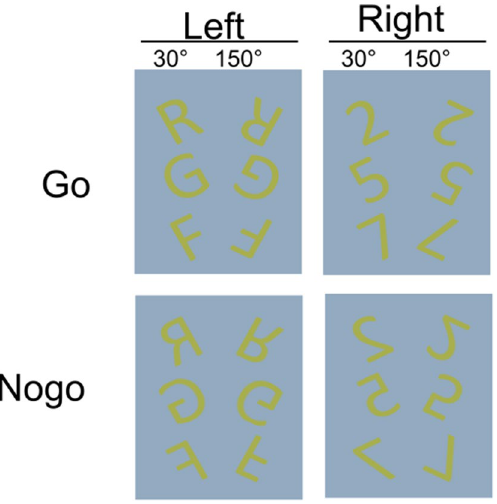
Figure 6. Stimulus categorization and corresponding responses. The colors of stimulus and the background are identical to the experiment’s colours. Each panel represents all possible stimulus with a specific response. All stimuli for Go and Nogo trials are